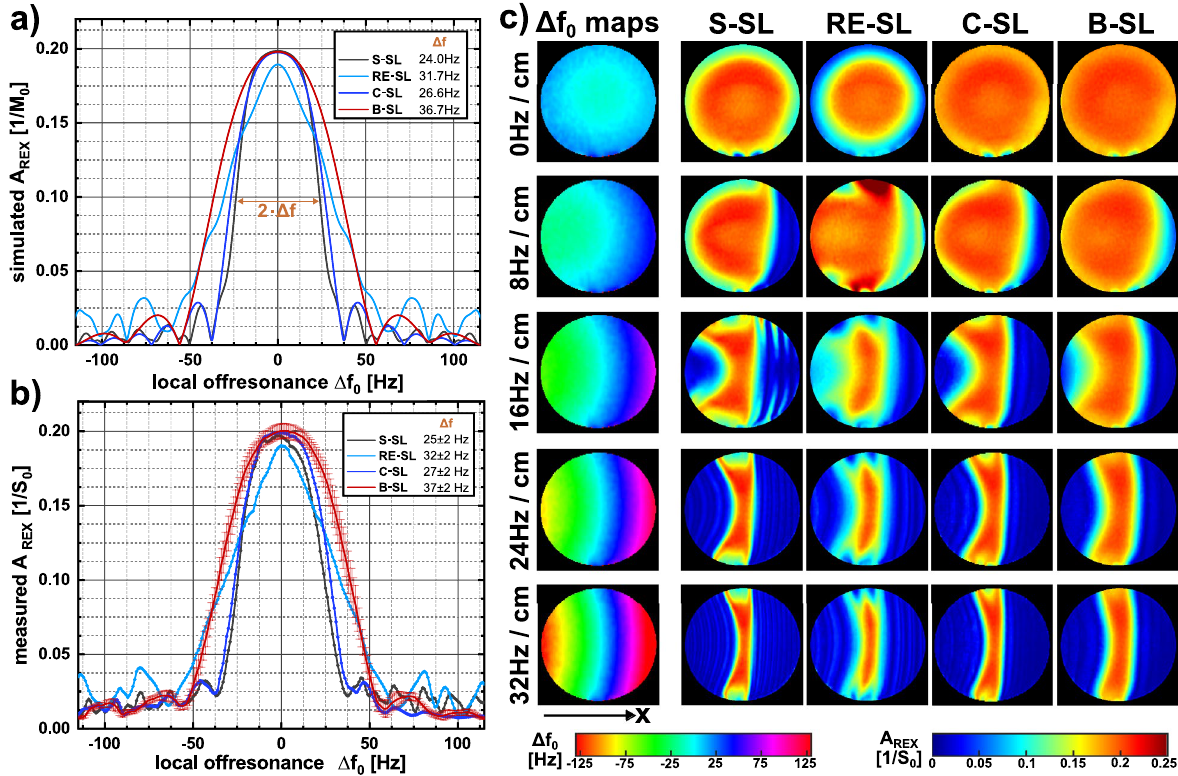
Figure 6. Performance of the REX modules in the presence of static B 0 field inhomogeneities. Subfigure ( a ) shows the Bloch-simulated A REX amplitudes, calculated for an offresonance range between − 1…1 ppm in 0.004 ppm steps (1 ppm ≙ 127.7 Hz at 3 T). Further simulation parameters were f SL = f stim = 50 Hz and (cid:31) B stim 0 = 50 nT. The simulation was performed for optimal SL times 77.5 ms (S-SL), 70 ms (RE-SL), 80 ms (C-SL) and 80 ms (B-SL). The choice of these parameters is justified with respect to the results of the previous simulations (t SL characteristics). The signal maximum is symmetrically distributed around zero and shows the widest maximum for the B-SL module. For offresonances > 50 Hz all modules indicate an oscillatory behavior. Experimental data were generated by applying an additional constant gradient (x direction), which projects a spatially-dependent field inhomogeneity within the tREX slice. The amplitude performance was determined r ) were matched with the measured by an ROI-based evaluation in which the measured amplitudes A REX ( (cid:31) r ) . The measurement results were averaged in 1 Hz intervals and compared with the offresonances � f 0 ( (cid:31) simulation results. The signal amplitudes are plotted in ( b ) against the corresponding offresonance. For clarity, the error bars are only shown for B-SL. In ( c ), the field maps and the corresponding A REX maps are shown for different static field